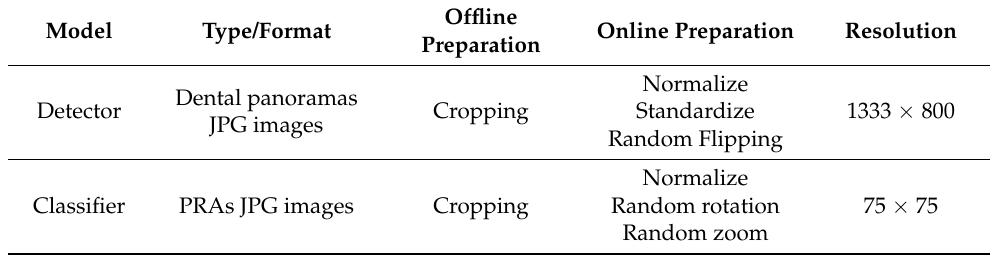
Table 1. Summary of Applied Data Preprocessing